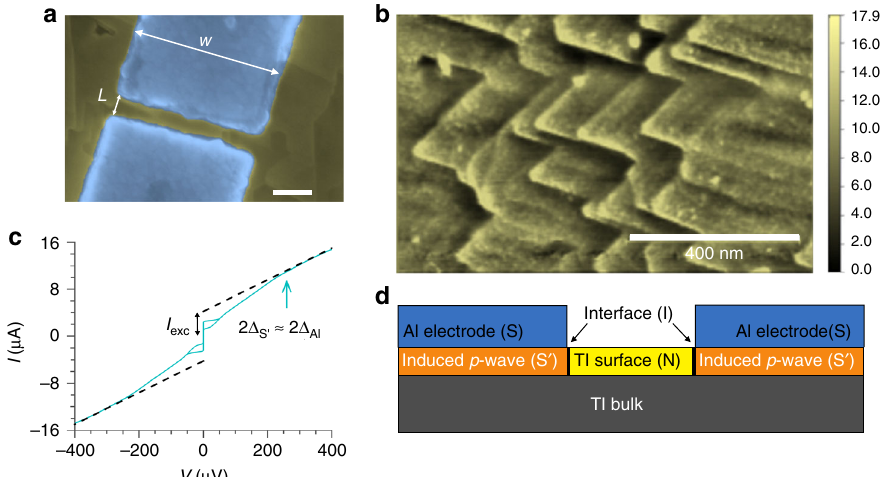
Fig. 1 Morphological and transport characterization of a typical proximity based Bi 2 Te 3 Josephson junction. a Scanning electron microscope image of a junction made using an exfoliated fl ake. The light blue areas de fi ne the Al/Pt electrodes while the Bi 2 Te 3 fl ake is shown in yellow. Scale bar: 200 nm. b Atomic force microscope image of a Bi 2 Te 3 thin fi lm grown on GaAs substrate showing a typical growth with aligned pyramidal domains. Scale bar: 400 nm. c IVC of a typical junction ( w = 1 µ m, L = 200 nm) measured at 20 mK (cyan). The resistive branch shows a neat change of slope at a voltage V ≈ 260 μ V (cyan arrow) that corresponds to ~2 Δ Al for the thickness of the electrodes 22 . The black arrow indicates the value of the extracted excess current.